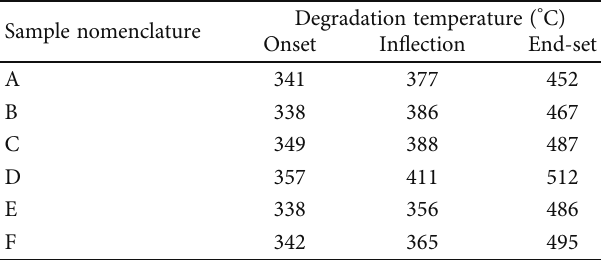
Table 2: Degradation temperature of the samples.